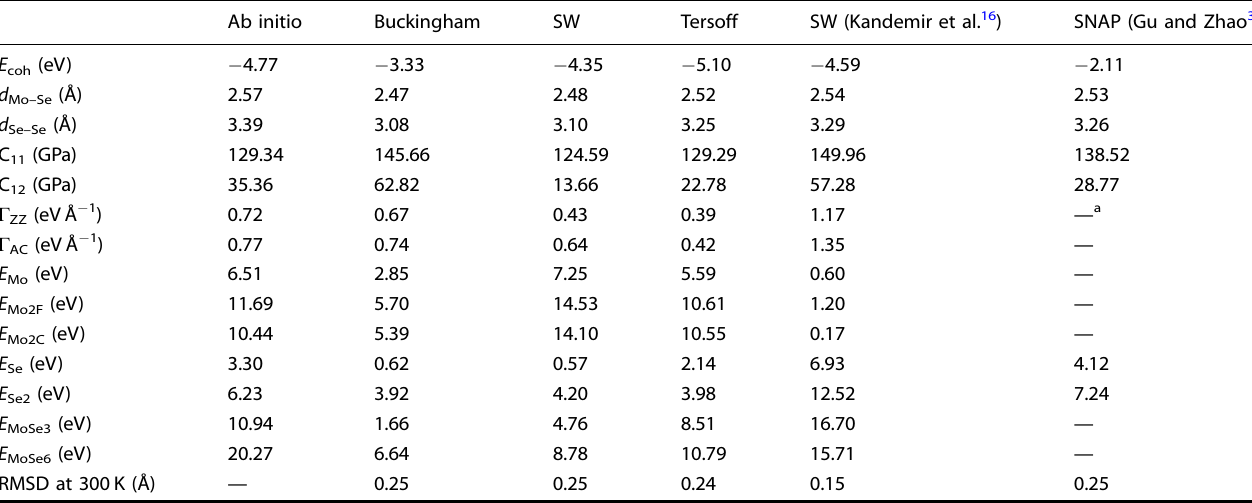
Table 1. Comparison of the parameterized interatomic potentials with ab initio